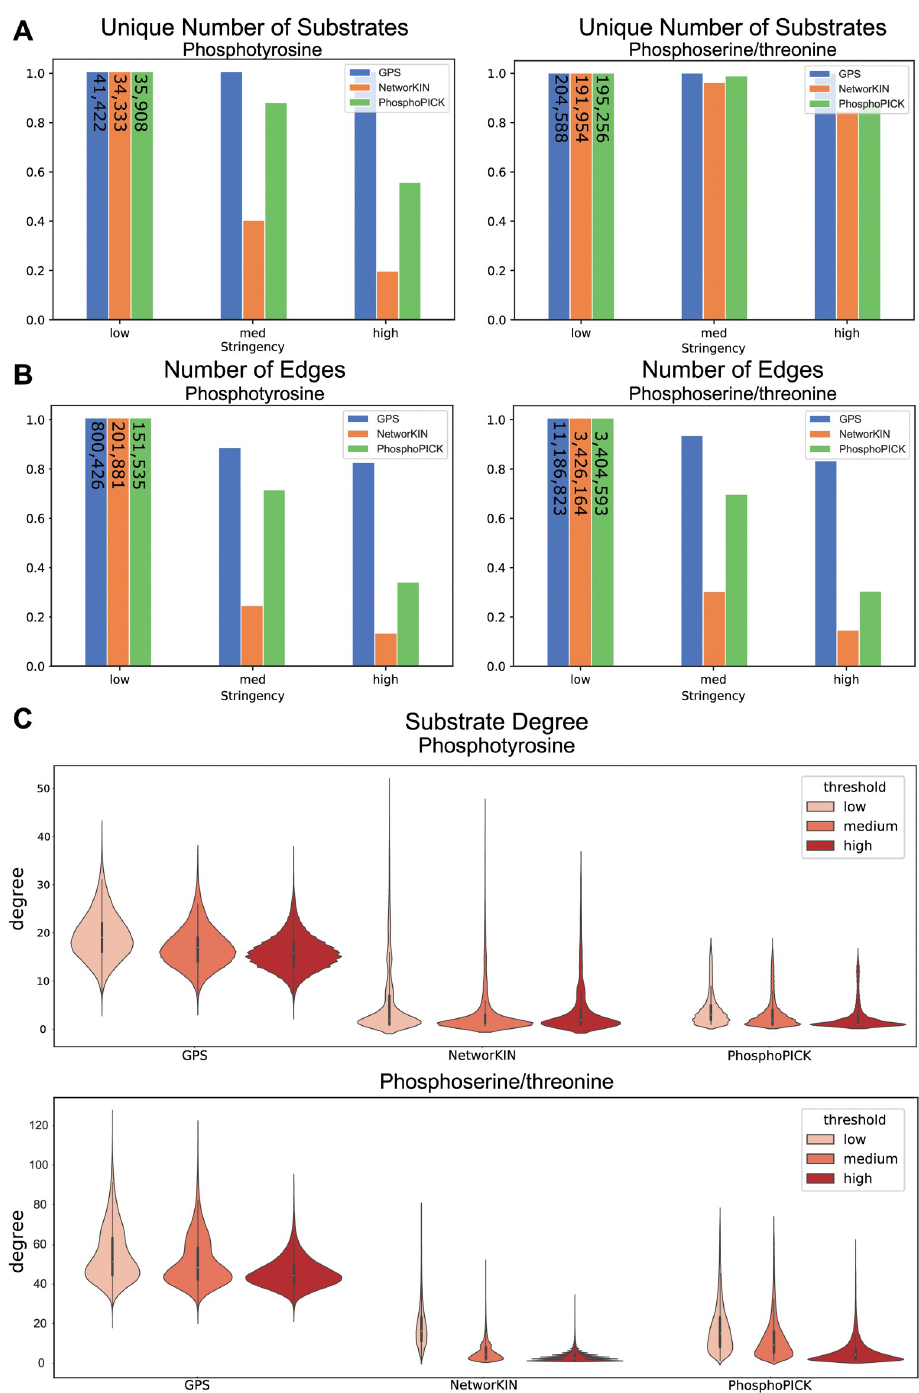
Fig 2. Network comparisons across stringencies. A: Bar graph of total phosphotyrosine and phoshphoserine/ phosphothreonine sites included in the network, normalized to the total number in the low stringency network, as a function of increasing stringency. Number of substrates at low stringency is labeled on each bar. B: Bar graph of total edges in the network, normalized by the total number covered in low stringency, as a function of threshold. Numbers on low stringency bars are the total number of edges at low stringency. C: Distributions of substrate degree of phosphotyrosine and phosphoserine/phosphothreonine sites, where degree is the number of edges connected to a substrate at or above the denoted